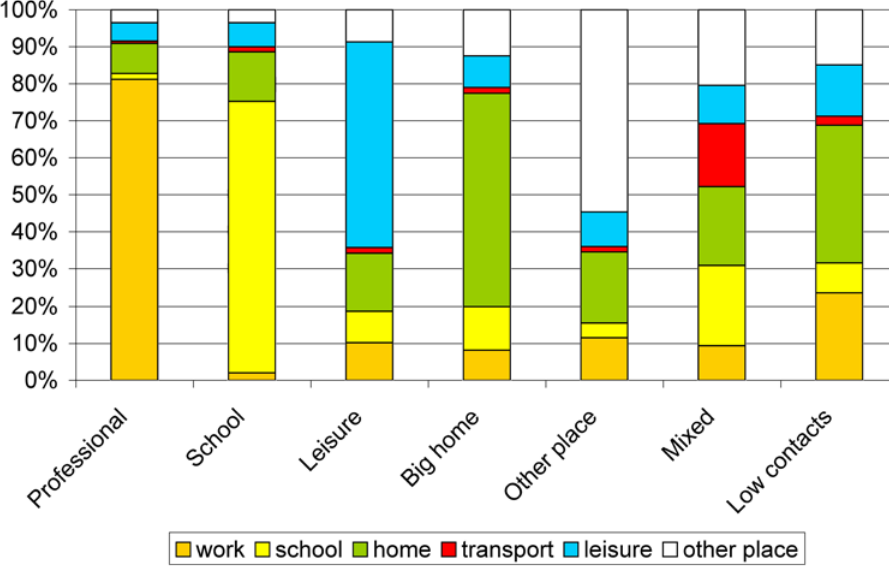
Figure 4. Distribution of contacts in different locations across the contact profiles.